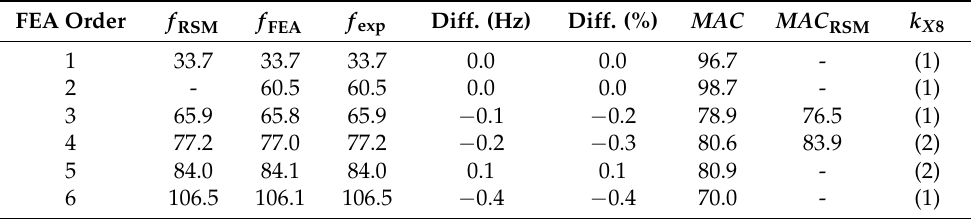
Table 14. Final frequency and MAC values.